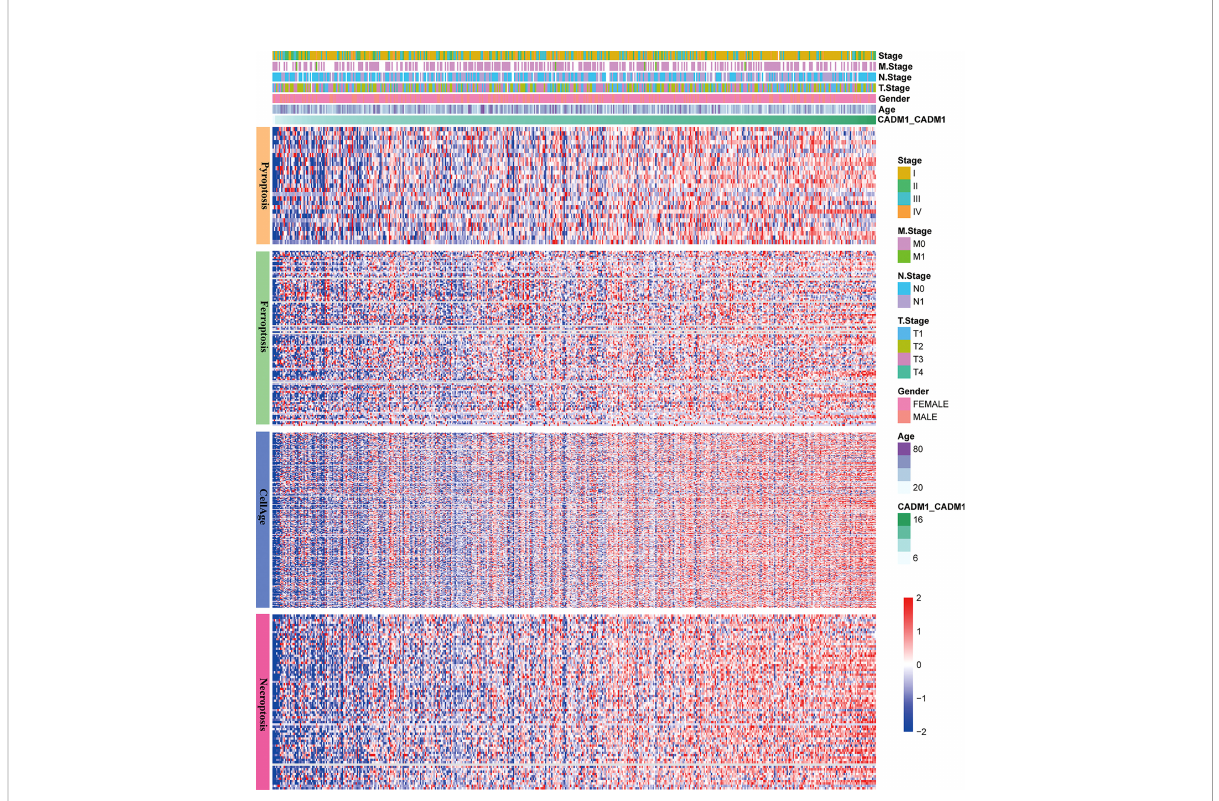
FIGURE 8 The relationship between CADM1-CADM1, gender, age, stage, T stage, M stage, N stage and genes associated with apoptosis, ferroptosis, pyroptosis and cellular